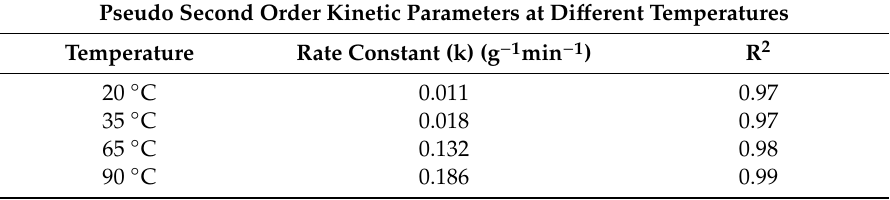
Table 6. Pseudo-second order kinetic parameters at di ff erent